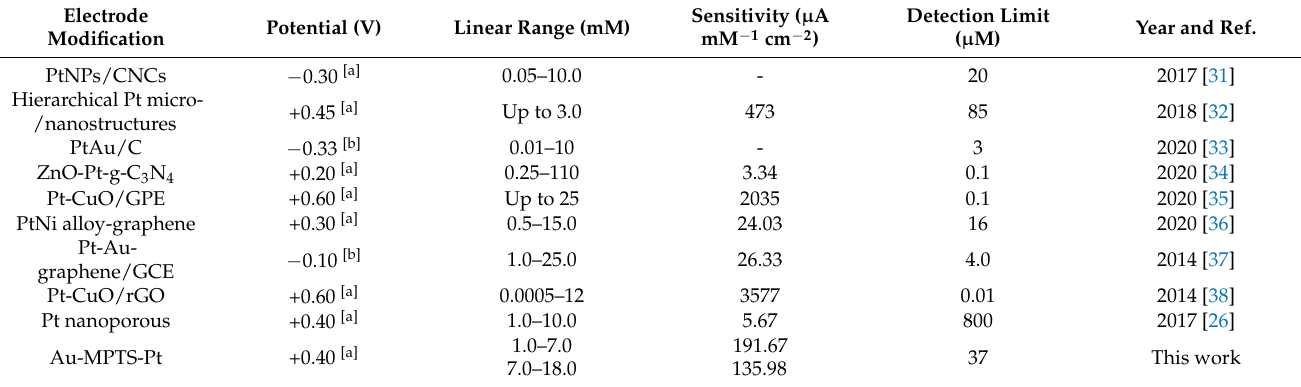
Table 1. Comparison of the performance of different platinum-based glucose sensors.